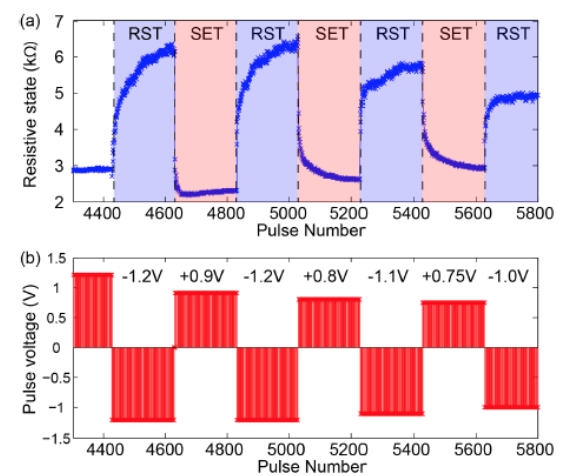
Figure 3. RESET and SET for TiO 2 with pulse within the hundred of microseconds, reproduced with permission from [47]. The subfigure ( a ) is the evolution of resistance as a function of the voltage, which is shown in subfigure ( b